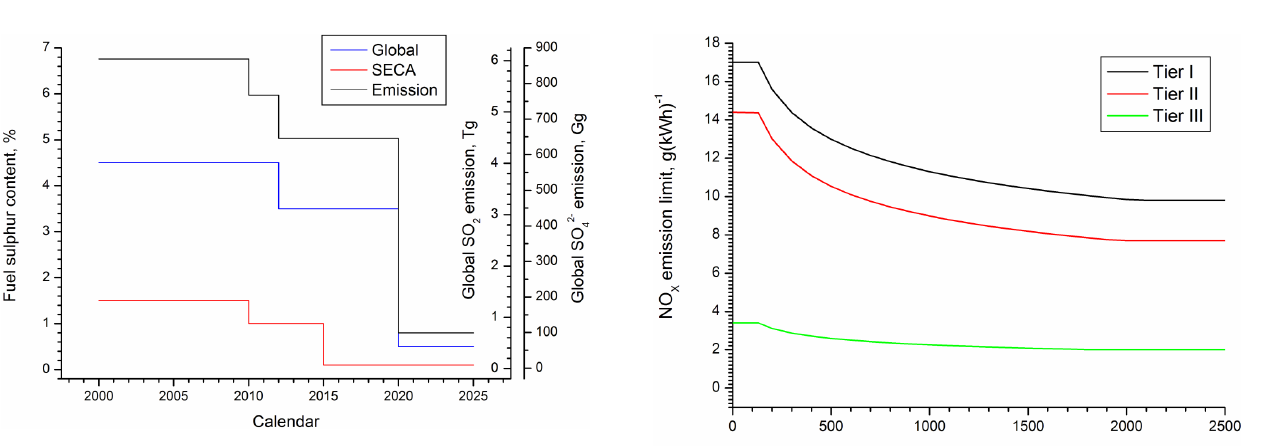
Fig. 1. Timeline for the reduction of sulphur content in fuels, glob- Figure 1. Timeline for the reduction of sulphur content in fuels, globally and in 968 ally and in SECAs. Calculated and predicted global SO 2 and SO 42 − SECAs. Calculated and predicted global SO 2 and SO 42- emission are also plotted in 969 emission are also plotted in accordance with the change of the esti- accordance with the change of the estimated global average of fuel sulphur content. 970 mated global average of fuel sulphur content.